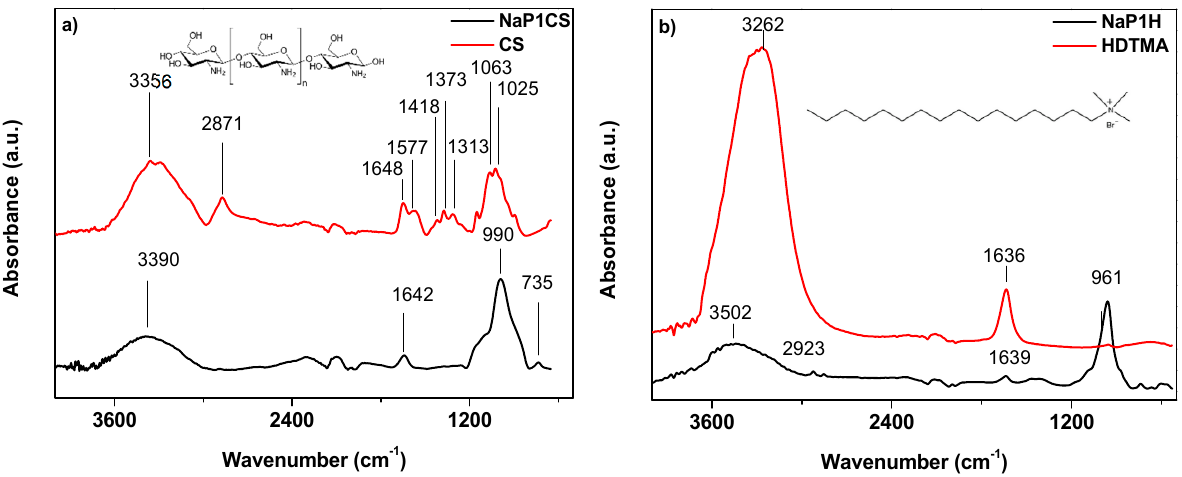
Figure 2. FTIR spectra of ( a ) CS and NaP1CS as well as ( b ) HDTMA and NaP1H.